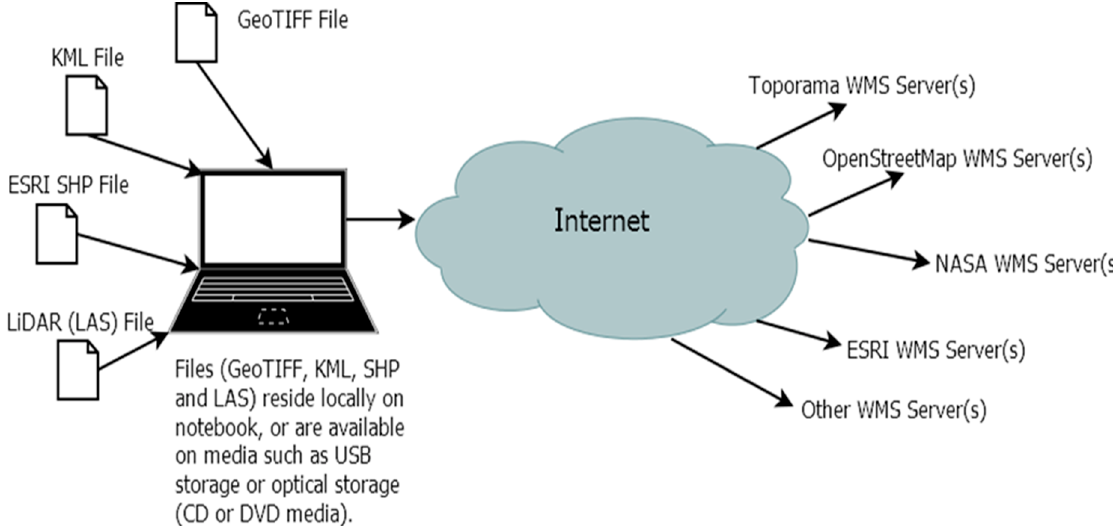
Figure 1. Various file formats and protocols used by geospatial data vendors/suppliers.